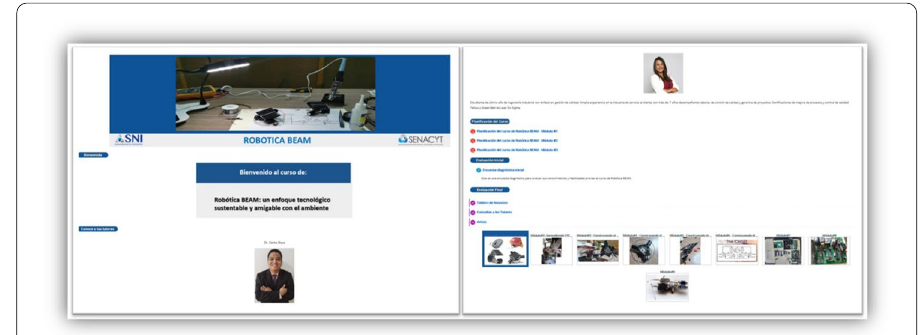
Fig. 5 Images of the BEAM robotics course in Moodle. The welcome is shown with the tutors and the nine modules, each with a specific learning topic